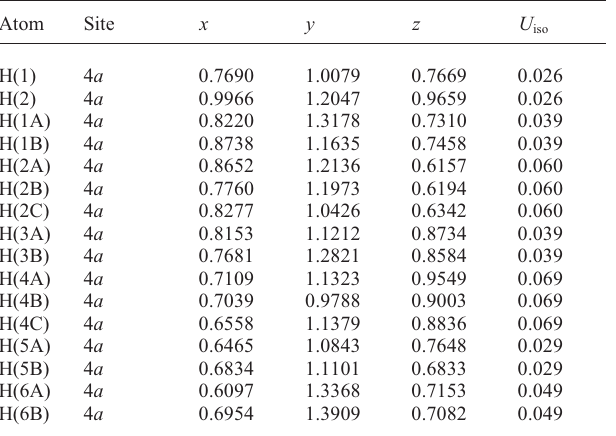
Table 3. Atomic coordinates and displacement parameters (in Å 2 )